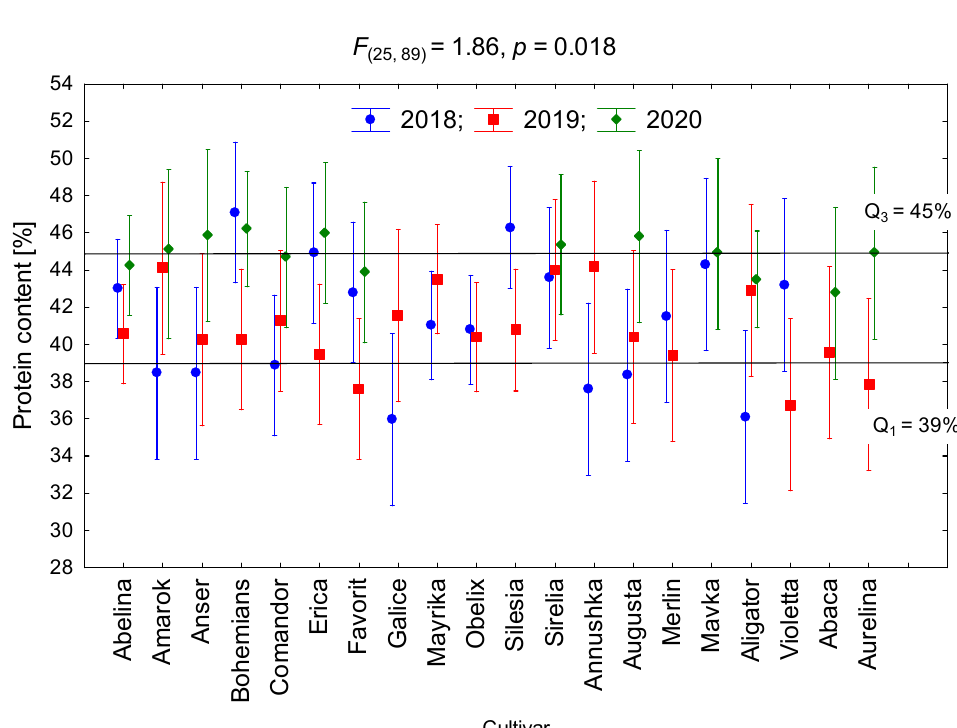
Figure 3. The protein content in soybean cultivars (%). Means ± confidence intervals ( p = 0.95) from sites in Central Poland.